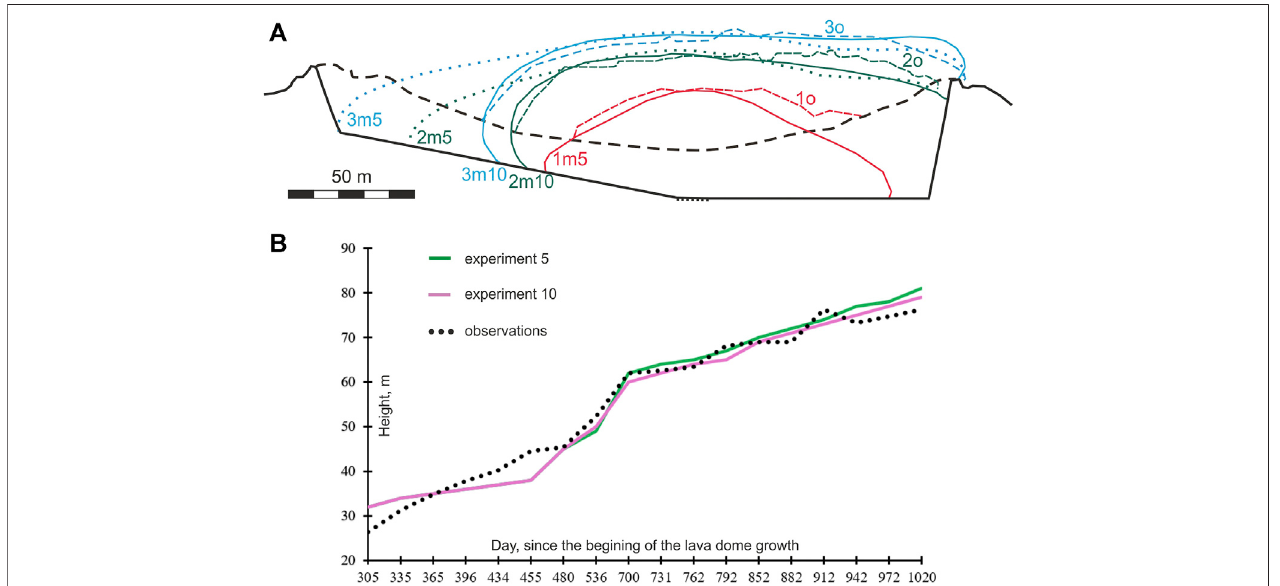
FIGURE11| Lavadomegrowth inexperiment10. (A) Comparison ofthemorphologicalshapesofthemodeleddomeinexp.10(solidcurveswithindexm10)with that in exp. 5 (dotted curves with index m5) and with observed lava domes (dashed curves with index o) on (1) May 1, 2008 (red curves), (2) December 4, 2008 (green curves),and(3)April1,2009(bluecurves).Theblackdashedlineisthecrater ’ srim.Theblackboldlinepresentsthebaseofthecrater,andtheblackdottedlineisthetop oftheconduit. (B) ComparisonofthemaximumheightsatthecenterofthelavadomeatVolcándeColima(Bretón-Gonzálezetal.,2013)withthoseofthemodeled dome in exp. 10 (purple curve) and in exp. 5 (green